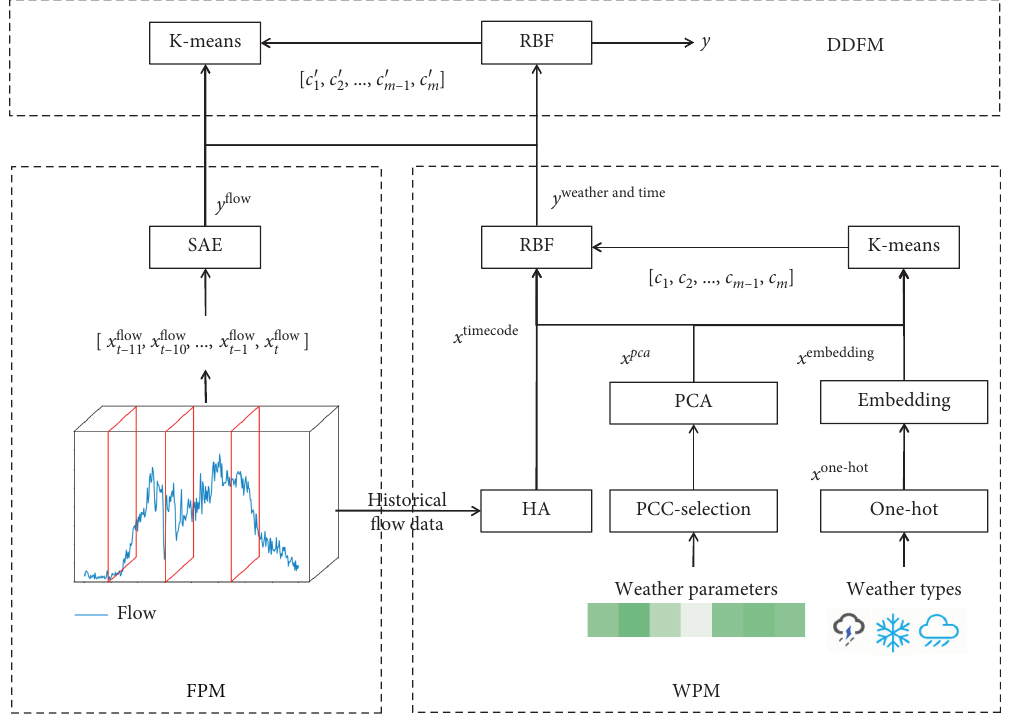
Figure 4: The combined framework of SAE and RBF.